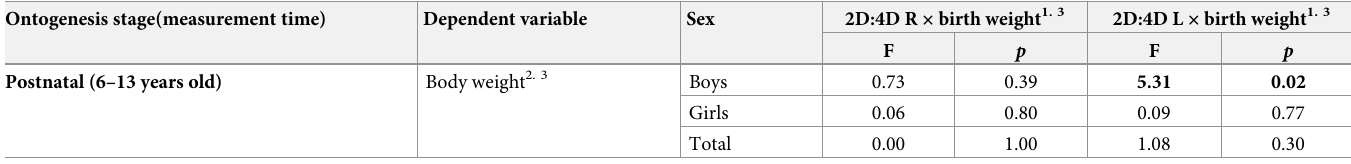
Table 5. Assessment of significance of the interaction between 2D:4D R and birth weight explaining body weight variability in children during postnatal